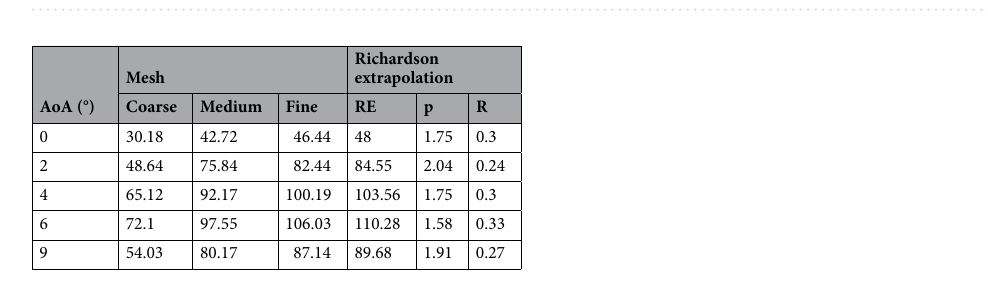
Table 1. General Richardson extrapolation results for the lift-to-drag